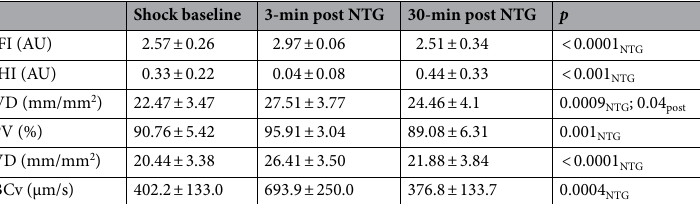
Table 4. Microcirculation measurements during NTG challenge. Values are given as the mean ± SD. One-way repeated measures ANOVA with Tukey correction performed compared to baseline assessment. Significant difference relative to baseline measurement for 3-min post NTG challenge reported as “NTG” and 30-min after NTG challenge as “post”.